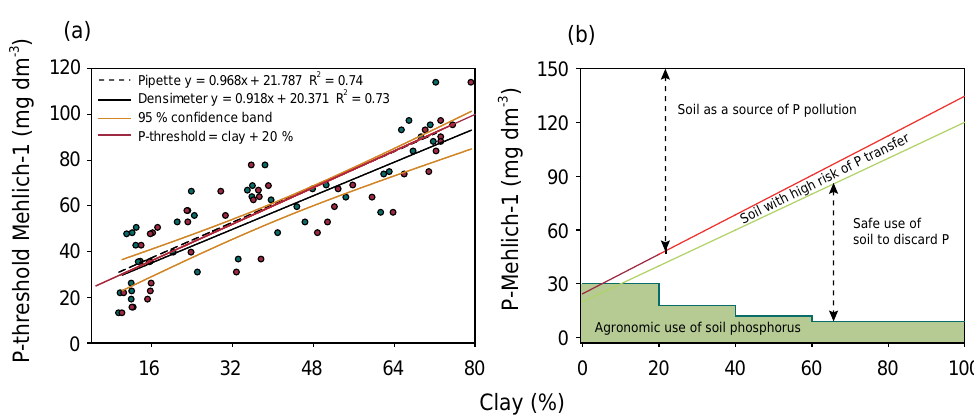
Figure 5. Real and simplified equations for the critical limit of P (P-threshold) indicated for soils of the state of Rio Grande do Sul (a), and critical levels of P for the annual grain crops according to CQFS-RS/SC (2016) and its relation to the P-threshold calculated through the “P-threshold = 20 + clay”